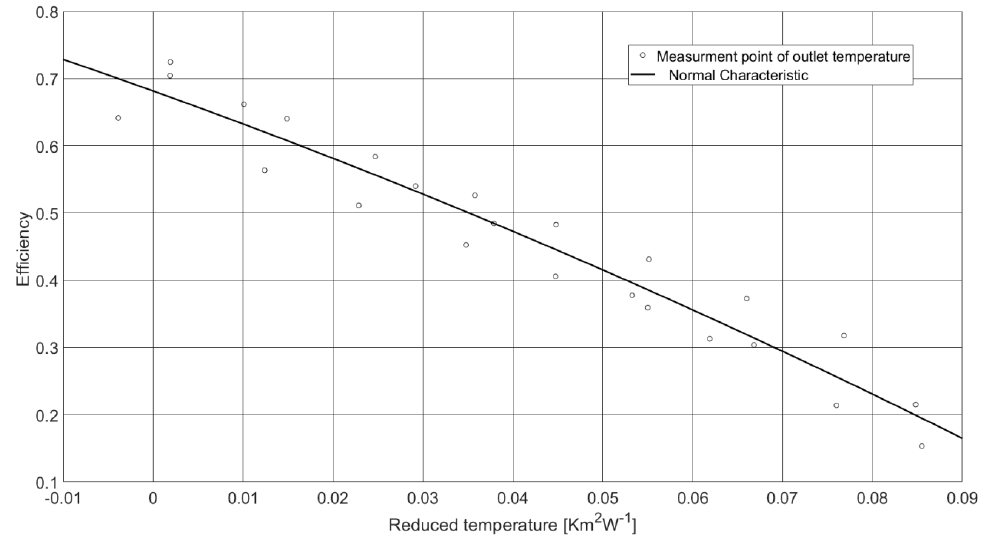
Figure 13. Efficiency characteristics of the collector heat loaded with a 100 dm 3 storage tank.